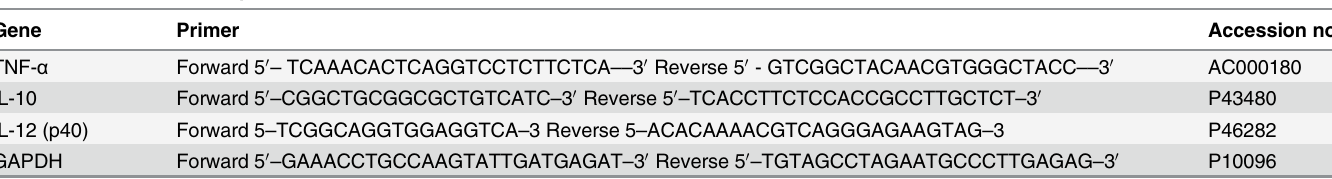
Table 1. Primers used for qRT-PCR.